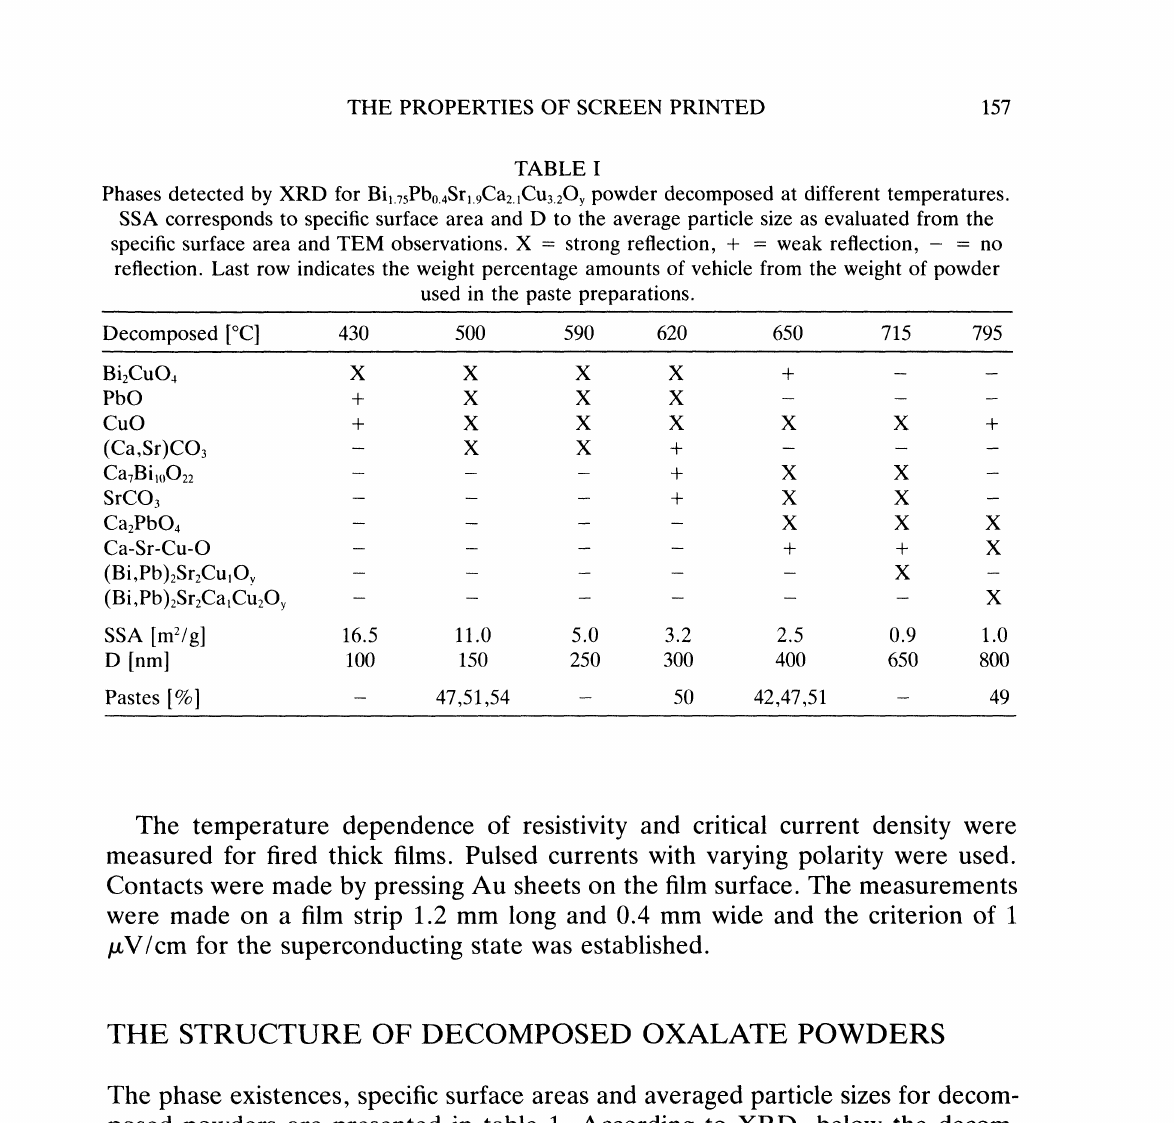
Phases detected by XRD for Bil.75Pb0.4Srl.9Ca2.1Cu3.2Oy powder decomposed at different temperatures. SSA corresponds to specific surface area and D to the average particle size as evaluated from the specific surface area and TEM observations. X strong reflection, + weak reflection, no reflection. Last row indicates the weight percentage amounts of vehicle from the weight of powder used in the paste preparations. Decomposed [C] 430